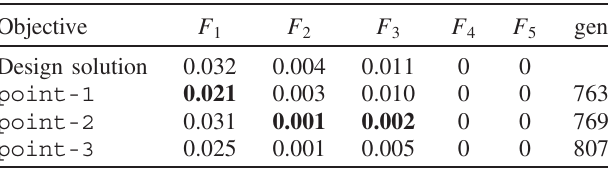
TABLE III. A comparison of the manually obtained design solution with three good points found in the optimization